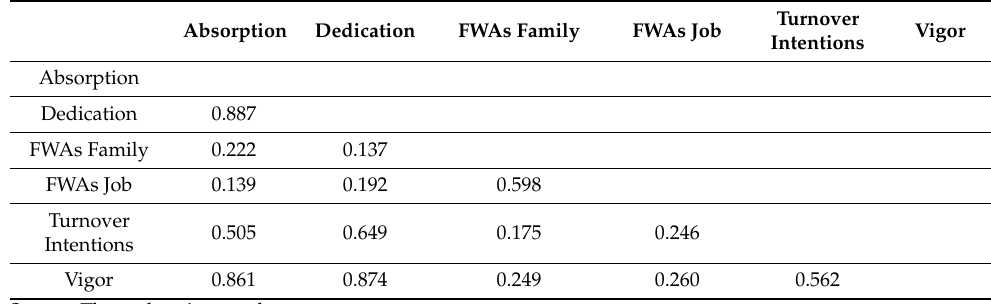
Table 10. Discriminant validity—heterotrait–monotrait (HTMT).